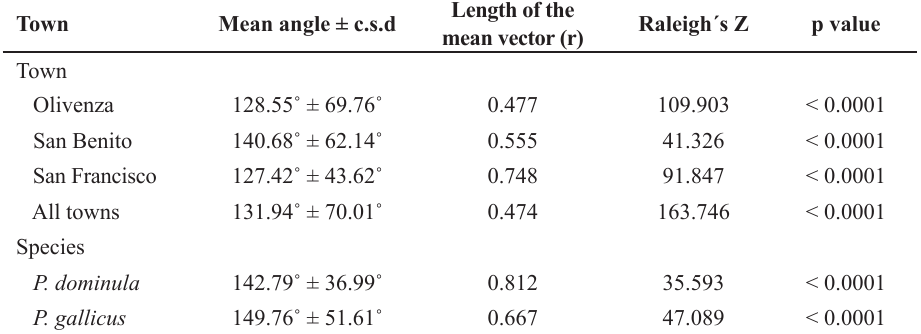
Table 3 . Nest orientations in the three sampled localities and by